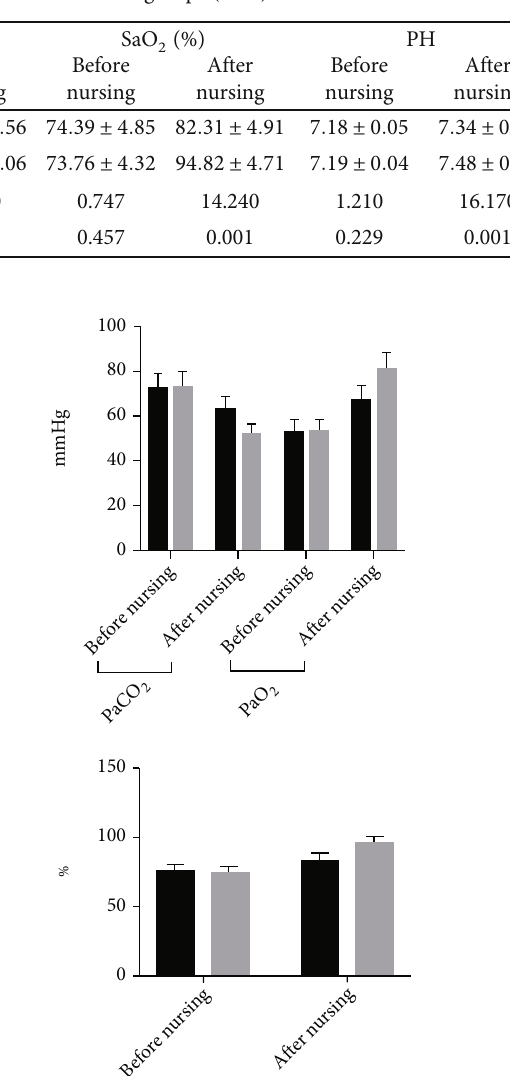
Table 4: Comparison of blood gas indicators between the two groups ( (cid:1) x ± s ).